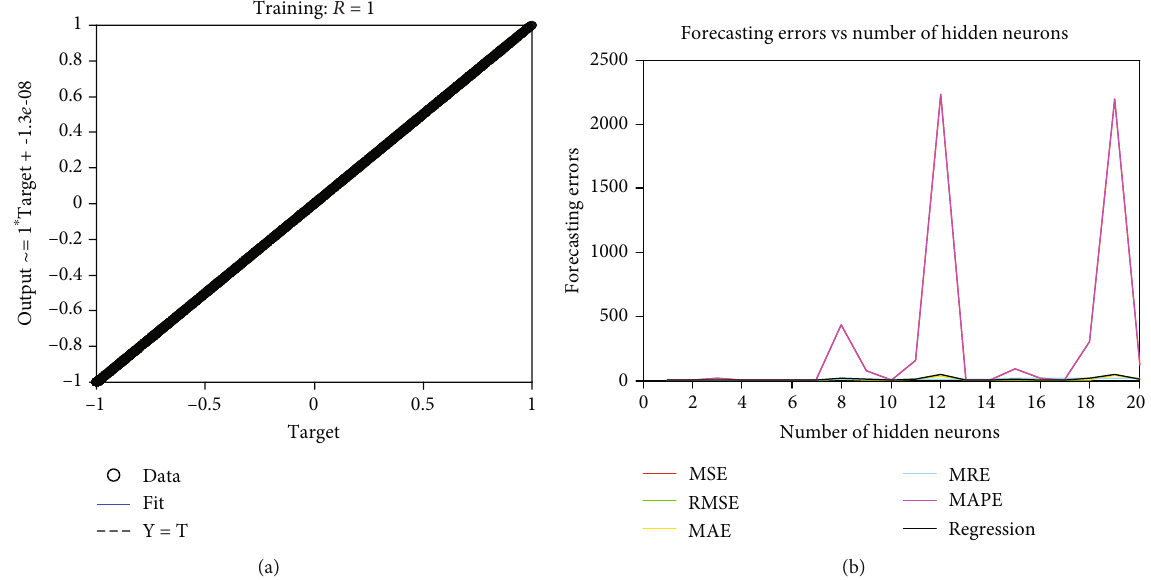
Figure 15: (a) Five input MLPNN-based forecasting model regression graphs. (b) Five input MLPNN-based forecasting model forecasting errors vs. the number of hidden neurons.